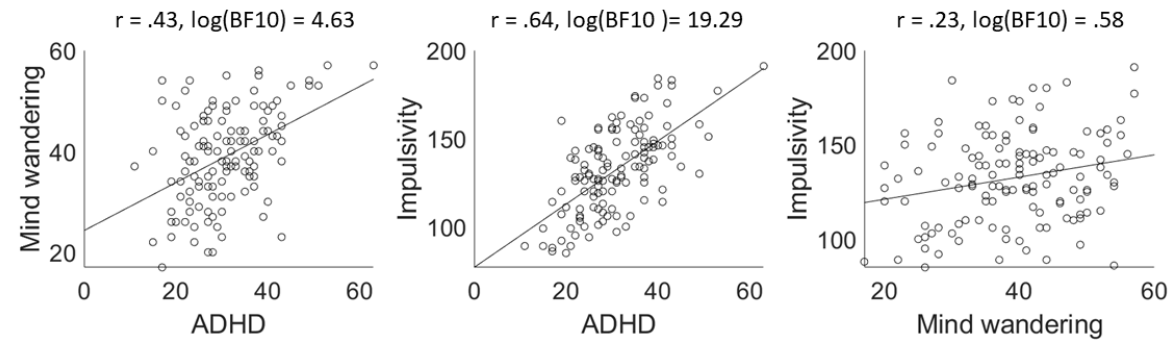
Figure 7. Correlational plots between self-assessed ADHD tendencies, mind wandering tendencies, and impulsivity, with accom- panying Pearson r and Bayes Factor values. ADHD tendencies are positively correlated with both mind wandering and impulsivity – replicating previous literature